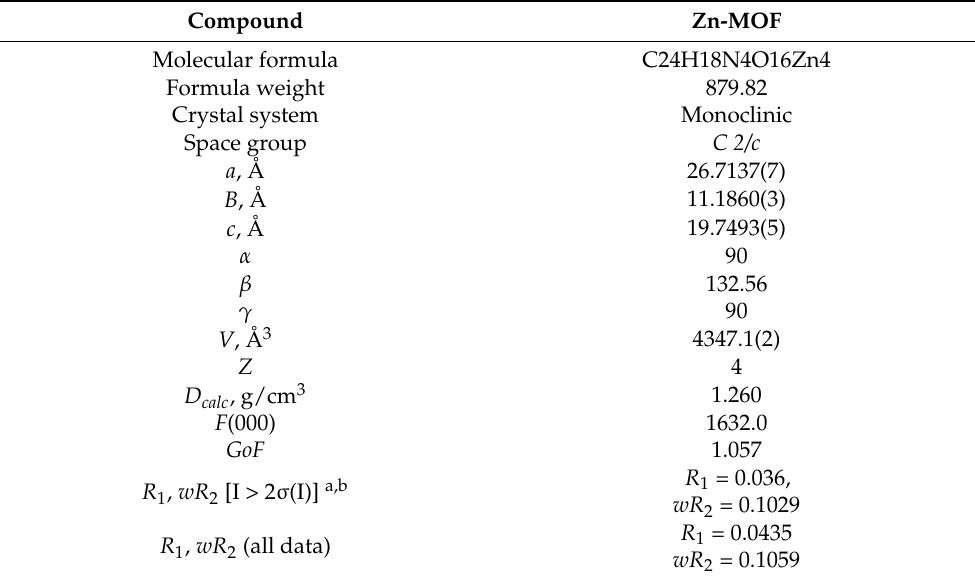
Table 1. Crystallographic data and structure refinement summary for the compound. Compound Zn-MOF Molecular formula C24H18N4O16Zn4 Formula weight